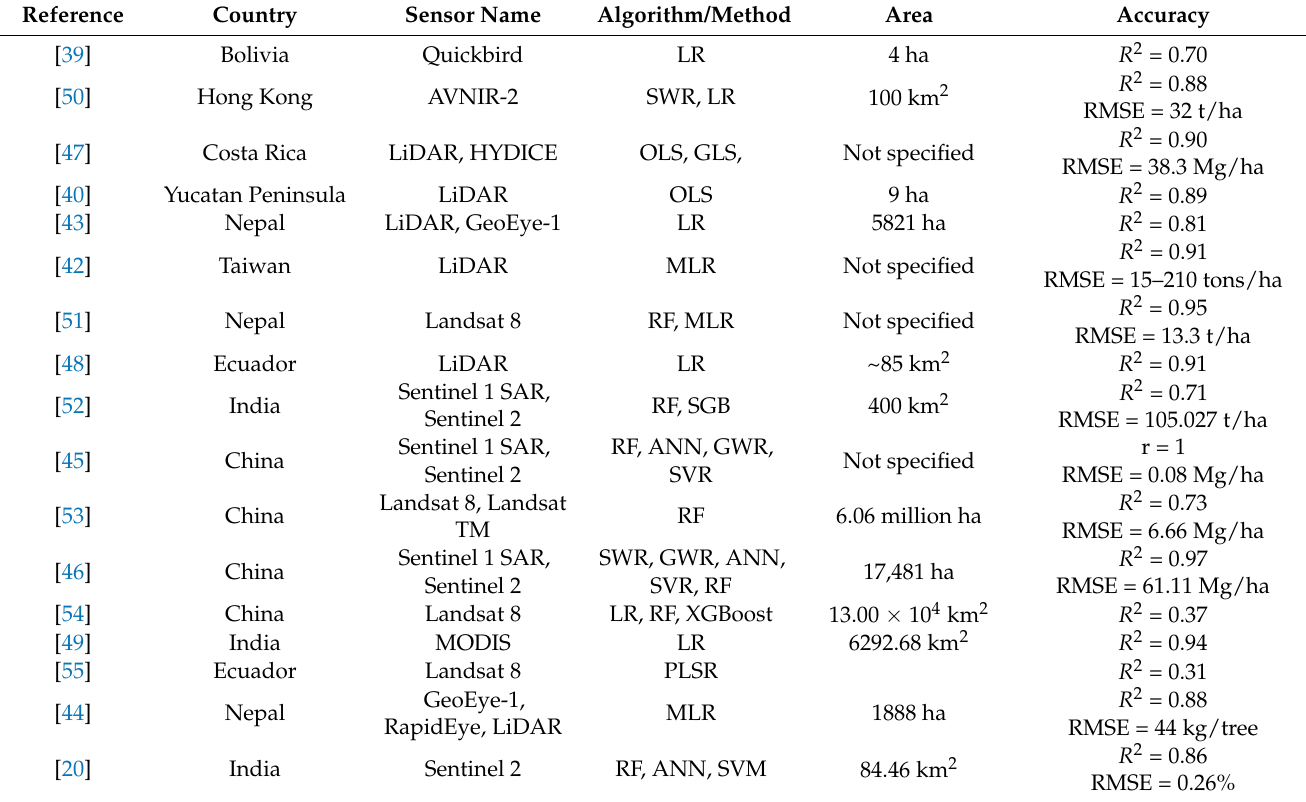
Table 1. Aboveground biomass and carbon estimation using remote sensing.